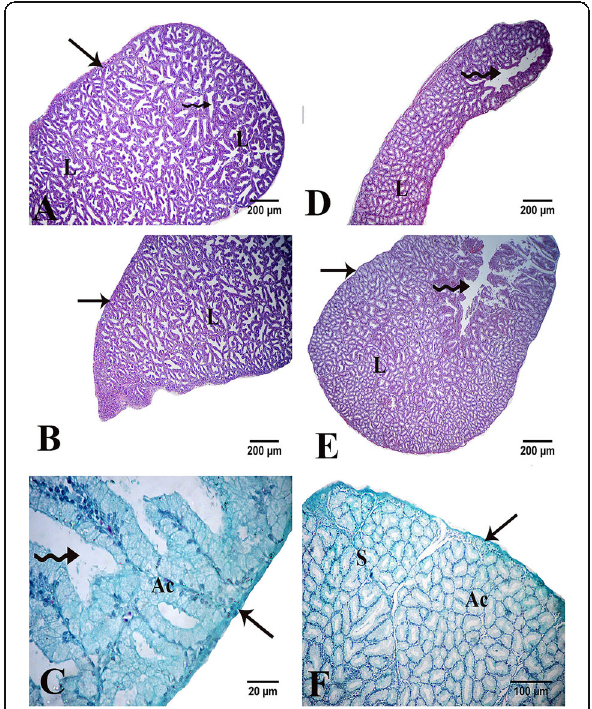
(2009) in geese. That was not in agreement with the statements of Brobby Sr (1972) in duck who stated that the duck HG had two secretory ducts but Burns (1974), employing careful dissection and India ink injection, could find only one.